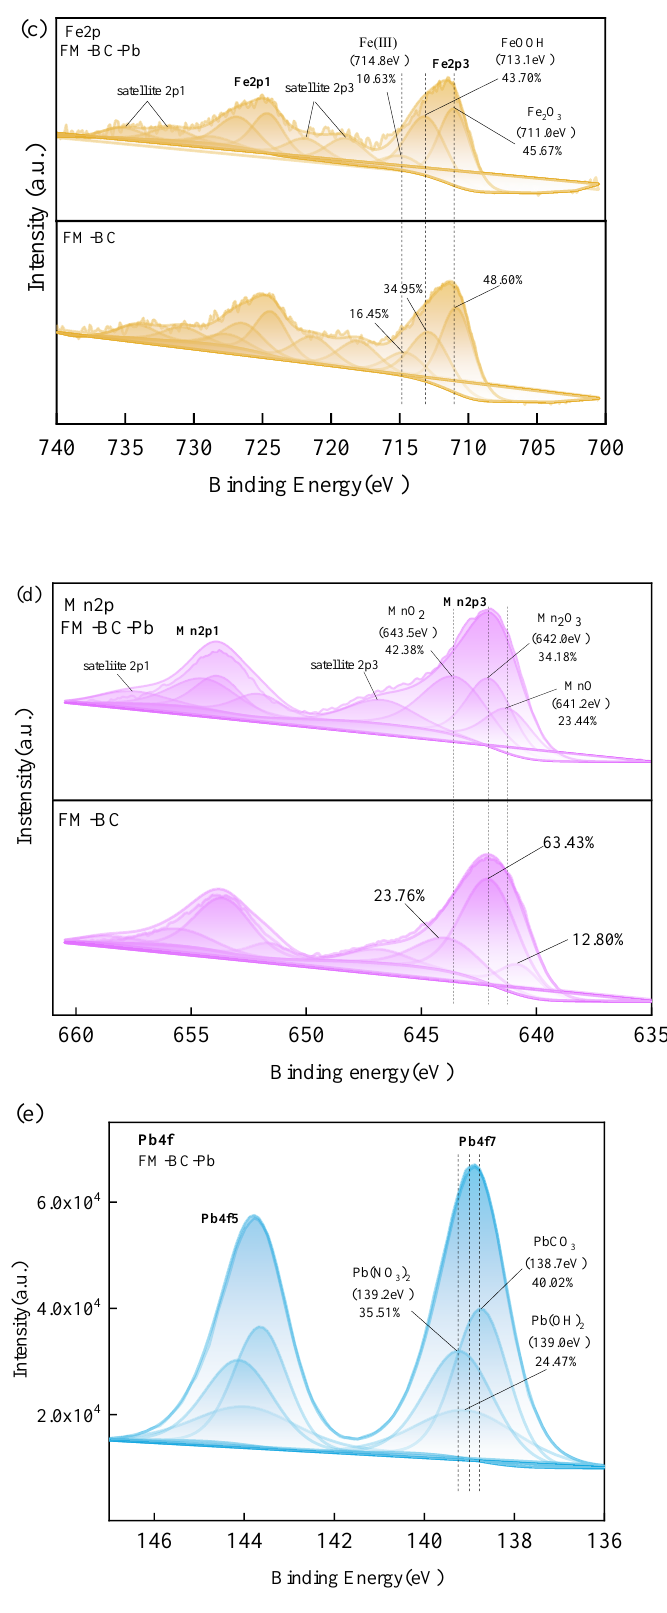
Figure 2. XPS spectrum of biochar ( a ) full scan spectrum ( b ) C 1s spectrum ( c ) Fe 2p spectrum ( d ) Mn 2p spectrum ( e ) Pb 4f spectrum.